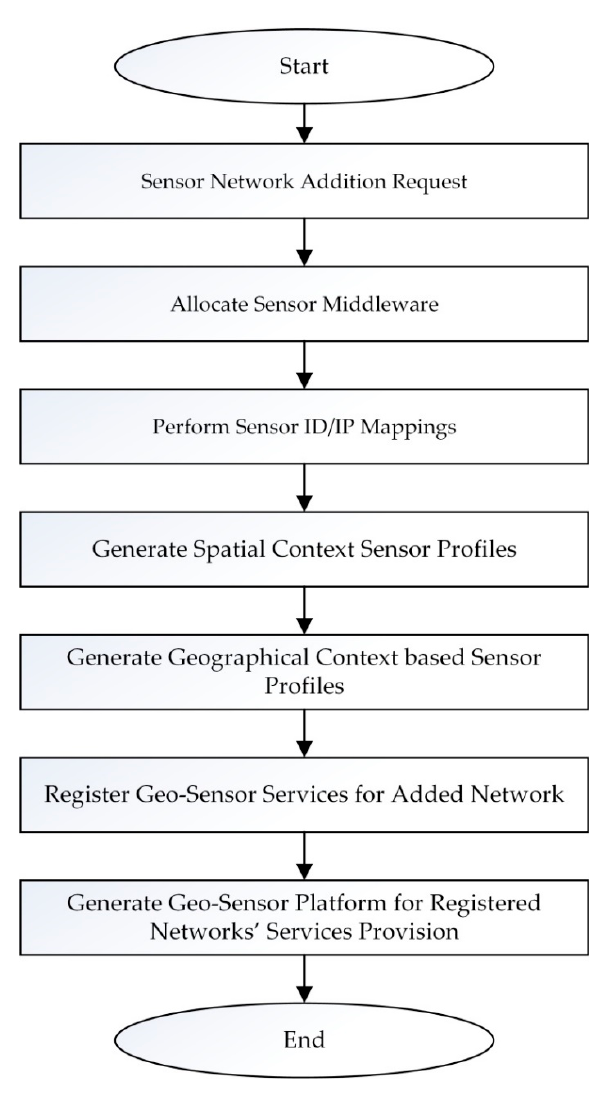
Figure 5. Geo-sensor platform’s generation procedure flowchart .